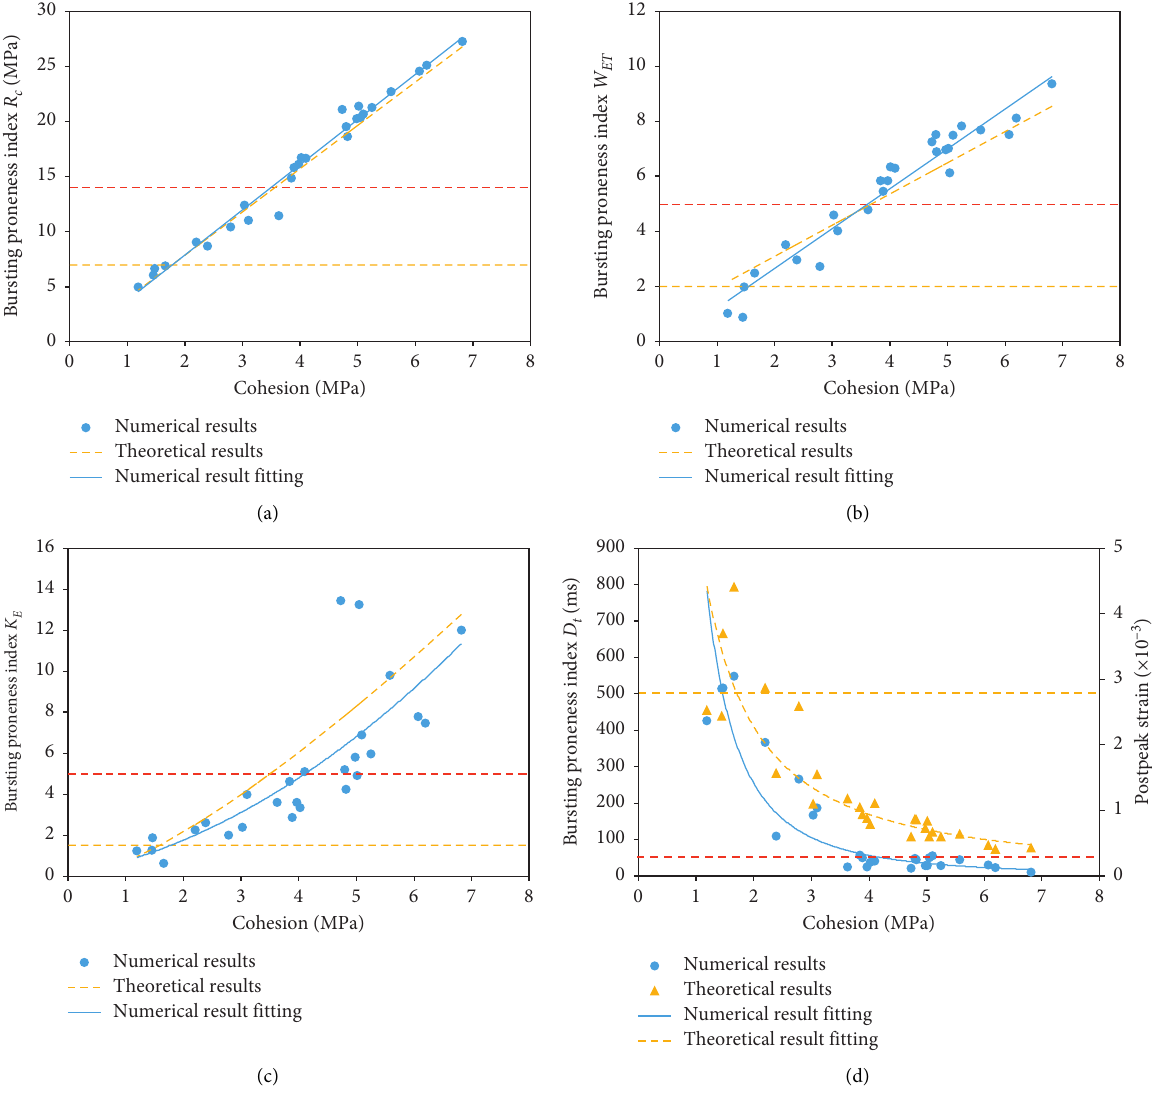
c (UCS). (b) Index W ET . (c) Index K E (d) Index D t